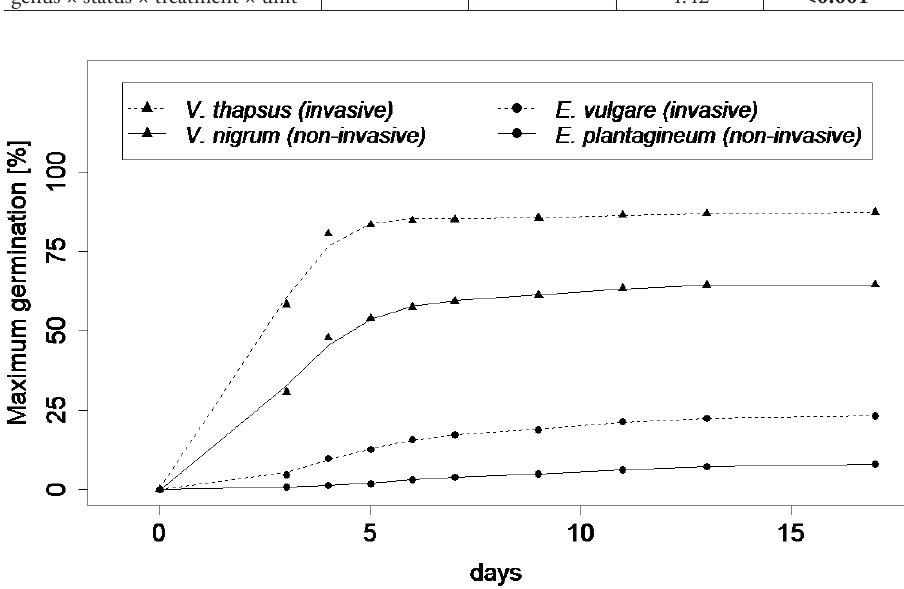
Figure 2. Germination development in the among-species approach testing for pre-adaptation of exotic (dashed line) and native species (solid line) of the genera Echium (circle) and Verbascum